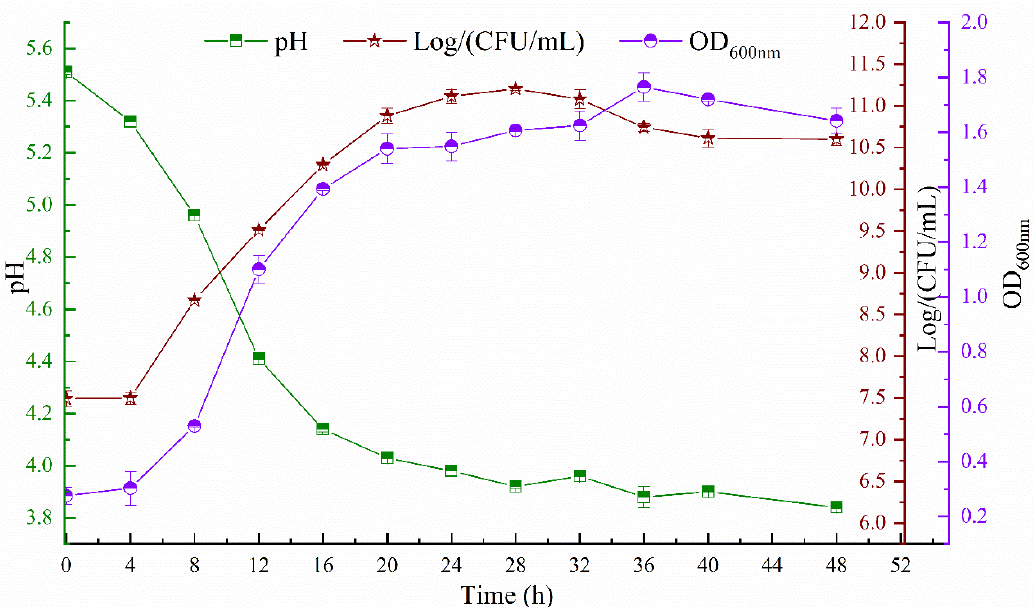
Figure 1. Kinetics curve of bacterial growth and pH values by L. paracasei GL1.